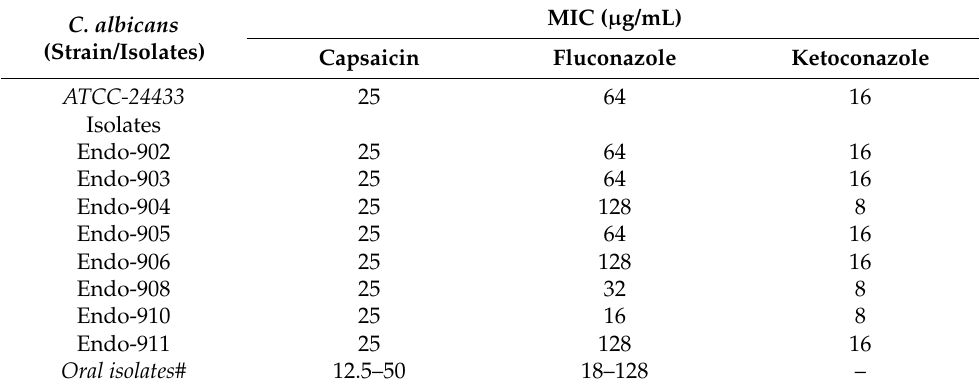
Table 1. MIC values of Capsaicin against C. albicans